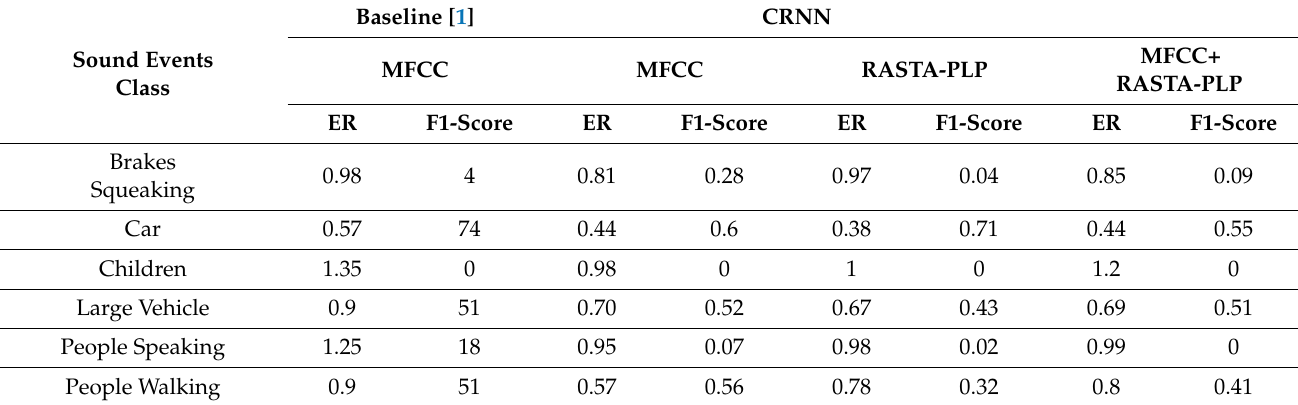
Table 5. Comparison of results using CRNN classifier on Dev-Set.